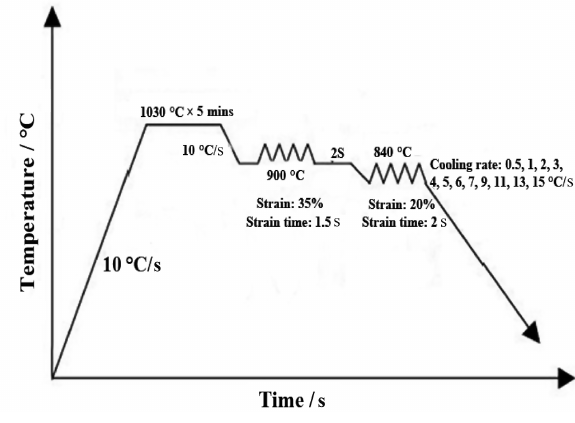
Figure 1: Schematic drawing of hot compression simulation tests.